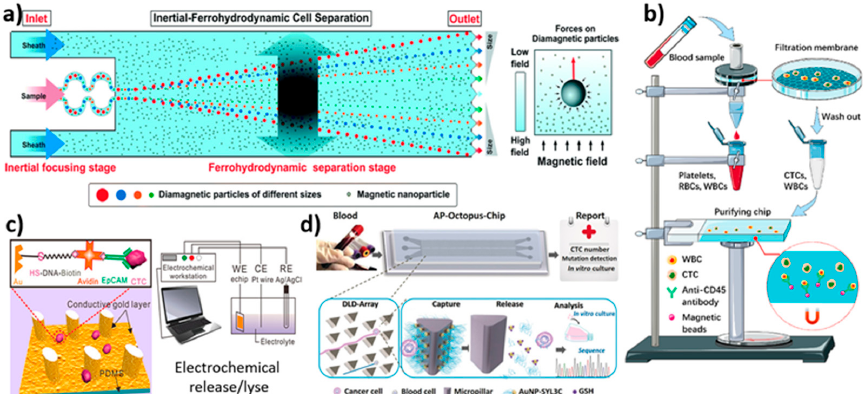
Figure 6. Schematic illustration of microfluidic devices for the isolation of CTCs using various techniques. ( a ) Schematic illustration of working principle of an inertial-ferrohydrodynamic cell separation chip in ferrofluids under a magnetic field; reprinted with permission from ref. [158], 2021, Royal Society of Chemistry. ( b ) Schematic of isolation of CTCs through filtration, followed by anti-CD45 antibody functionalized magnetic beads [115]. ( c ) Schematic illustration of e-chip exhibiting a conductive gold layer functionalised with EpCAM antibodies responsible for the capture and electrochemical release/lyse of CTCs; reprinted with permission from ref. [91], 2017, American Chemical Society. ( d ) Schematic of DLD working principle of AP-Octopus-Chip, where CTCs interact with micropillar-functionalised AuBO-SYL3C to get captured and released by Au-S bond disruption; reprinted with permission from ref. [161], 2019, John Wiley and